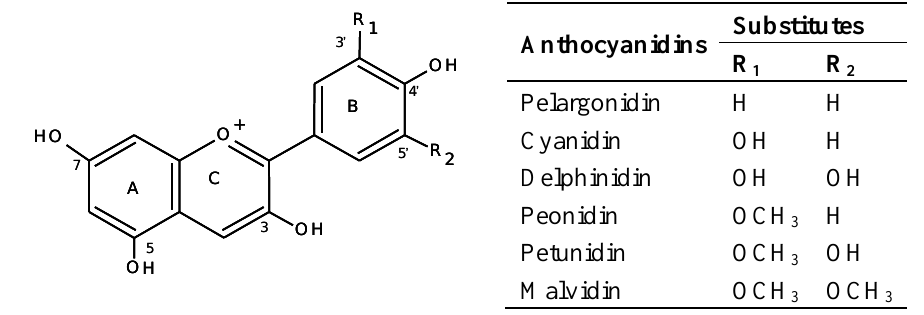
Figure 2. HPLC profiles of anthocyanins ( A ) and kaempferol-3,7-diglycoside ( B ) in radish brine.